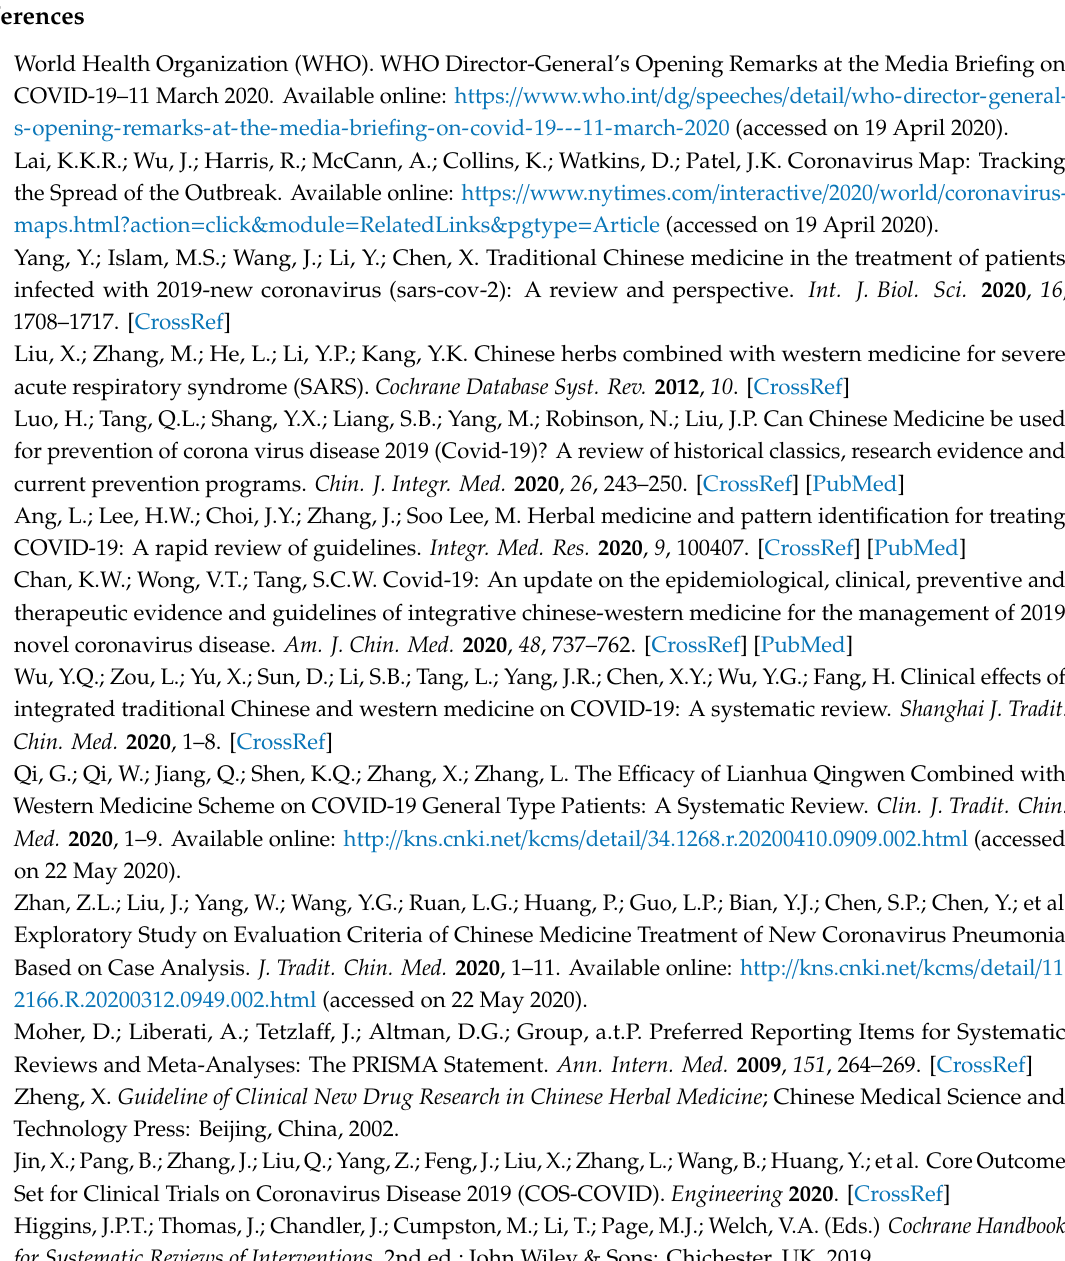
Table S1: The pattern identification and composition of herbs prescribed in Ye (2020)